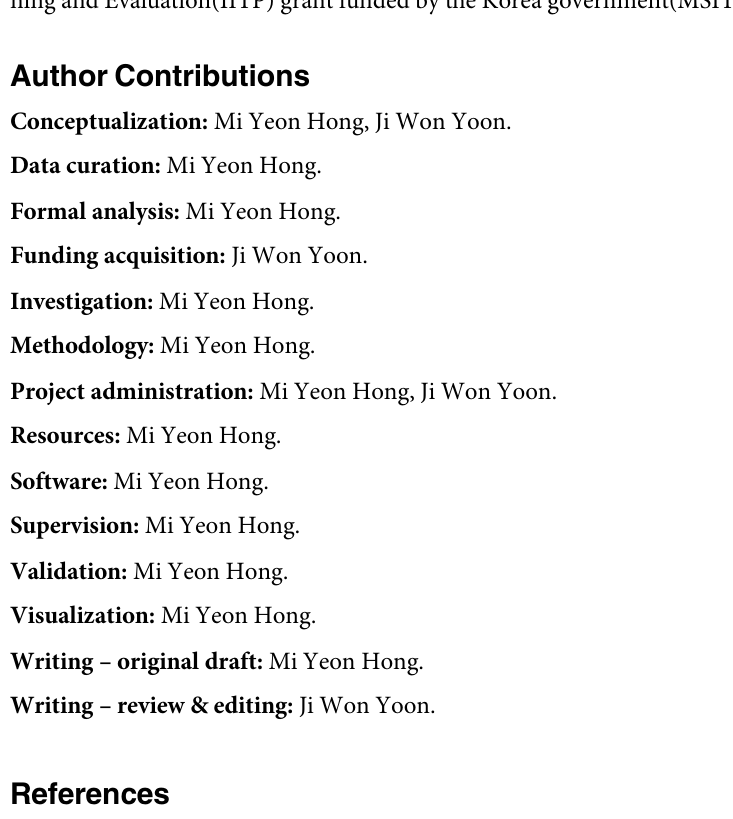
S3 Fig. Planar maximally filtered graphs in pre-COVID-19 using mutual information method. (PNG) S4 Fig. Planar maximally filtered graphs in post-COVID-19 using mutual information method.